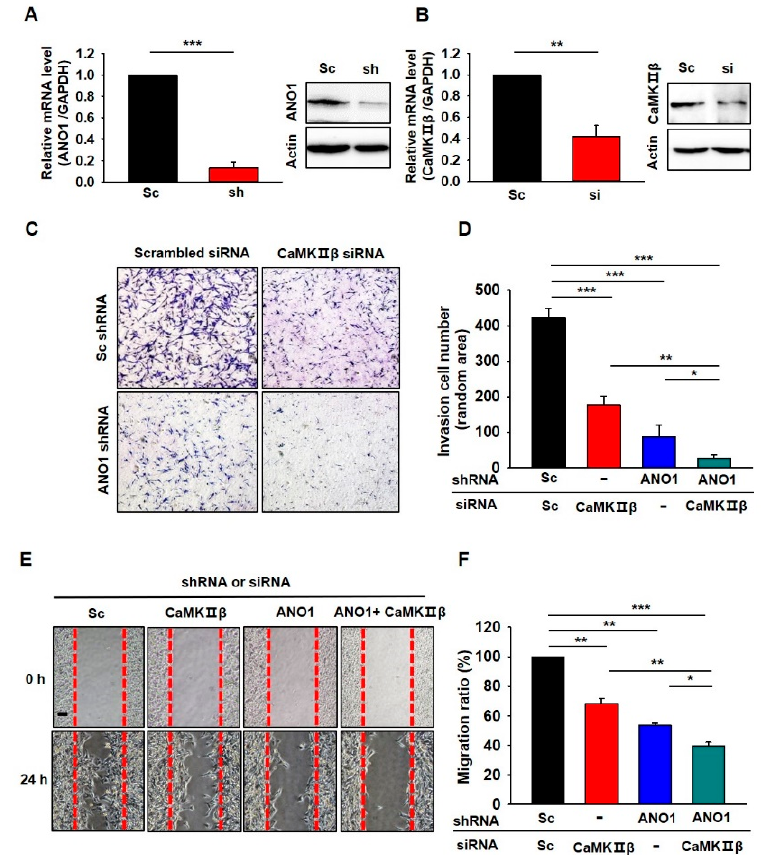
Figure 6. Inhibition of CaMKII β and / or ANO1 decreased migration and invasion of U87MG cells. ( A,B ) Validation of the silencing e ffi ciency of the Lenti-ANO1shRNA and the CaMKII β siRNA with qPCR and Western blot in U87MG cells. ( C ) Cell invasion assay of U87MG cells infected with Lenti-ANO1shRNA and transfected with CaMKII β siRNA. ( D ) The averaged bar graph shows the summary of (C), data obtained from three independent experiments. ( E ) Representative photographic images of the migration of U87MG cells infected with Lenti-ANO1shRNA and transfected with CaMKII β siRNA as compared to the cells with Lenti-Sc shRNA and Sc siRNA control. Scale bar, 100 µ m. ( F ) The averaged bar